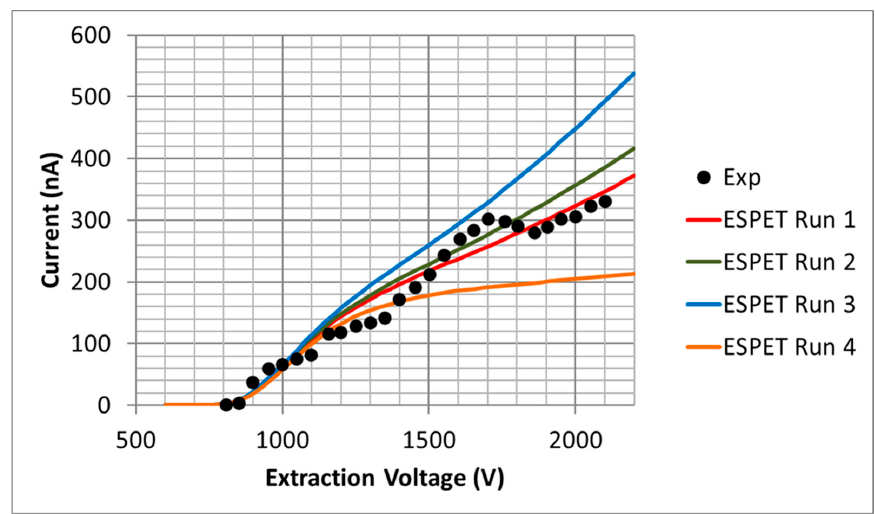
Figure 19. Comparison of positive polarity VI data of experimental measurements (Exp) and four ESPET QuickSolver runs consisting of a 1000 emitter average. Aerospace 2020 , 7 , 91